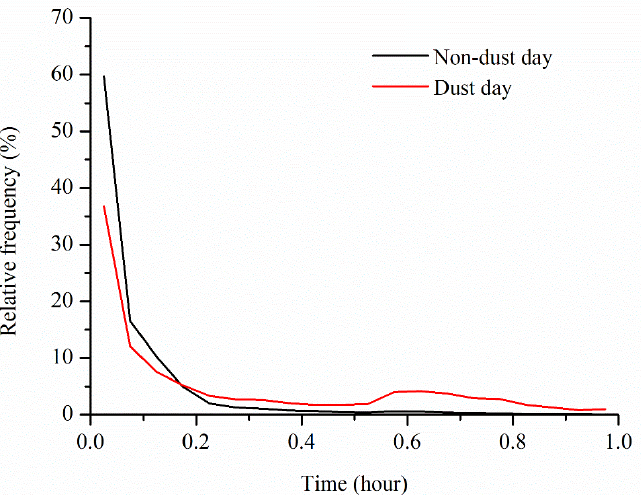
Figure 7. Relative distributions of hourly saltation time on dust and non-dust days.